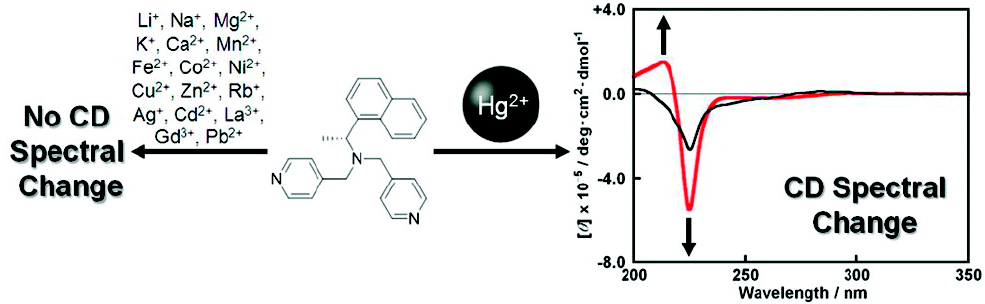
Figure 14. Hg 2+ induces circular dichroism (CD) changes in a chiral sensor while many other metal ions do not. Reprinted with permission from Reference [66]. Copyright (2012) American Chemical Society.